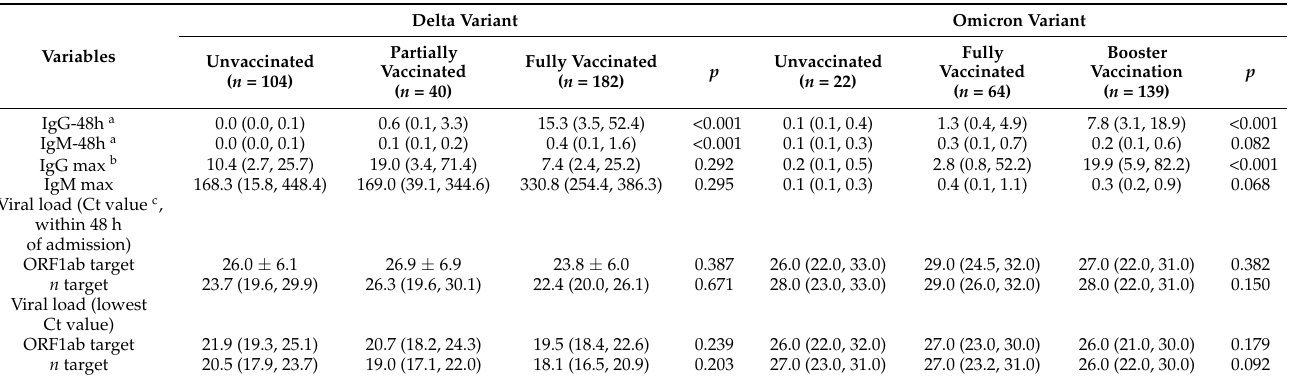
Table 2. Antibody titers and viral loads after the Delta and Omicron infections stratified by vaccina- tion status.